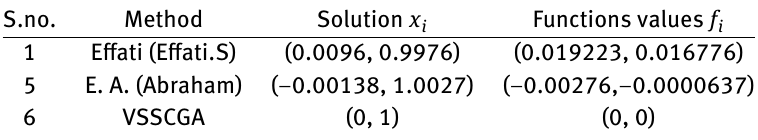
Table 6: Comparison of VSSCGA’s results with earlier results for Effati and Nazemi example 2 S.no.